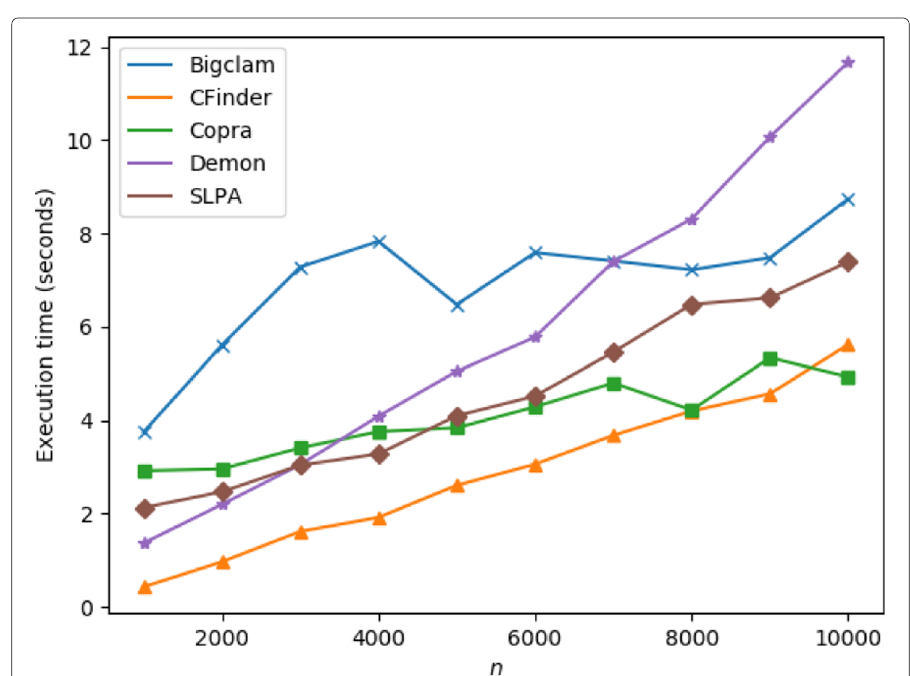
Fig. 1 Real-world networks considered in this